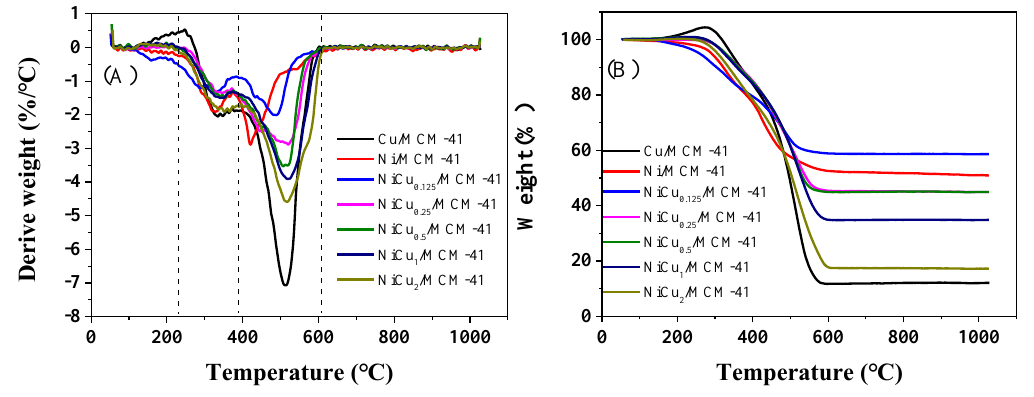
Figure 7. DTG ( A ) and TG ( B ) curves of catalysts after reaction.